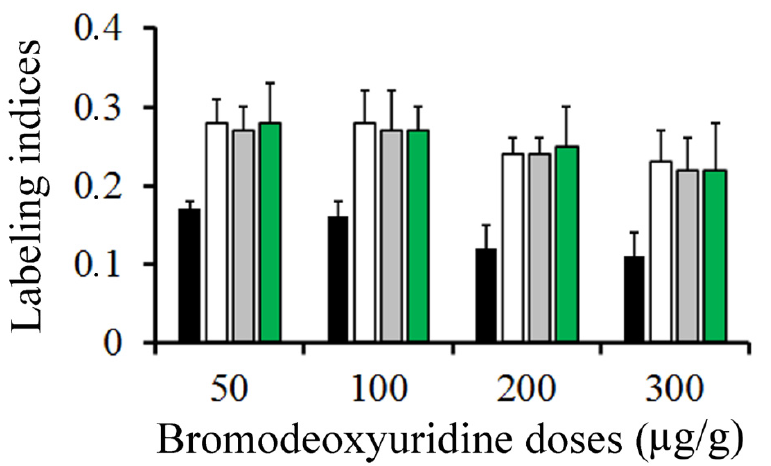
Figure 4. Mean values of labeling indices in the external granular layer. Animals were sacrificed at 0.5 (black columns), 1 (white columns), 1.5 (grey columns), and 2 h (green columns) after a single injection of bromodeoxyuridine at doses ranging from 50 to 300 µg/g.